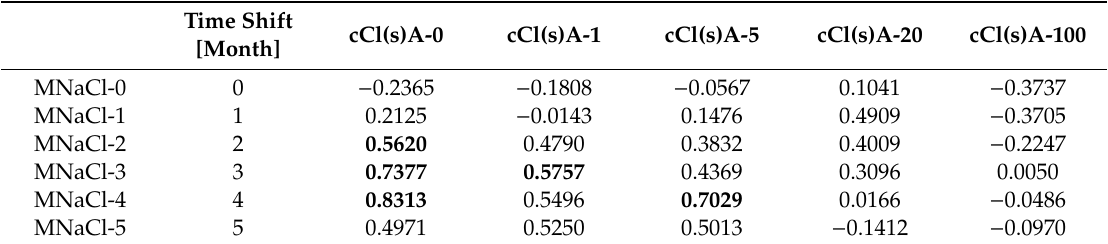
Table 7. Pearson correlation coe ffi cients between chloride concentrations in soils and the amount of applied de-icing salt—Site A. Sample size n = 13.